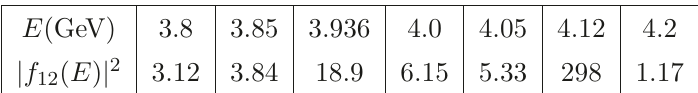
Table 3 . The values of the